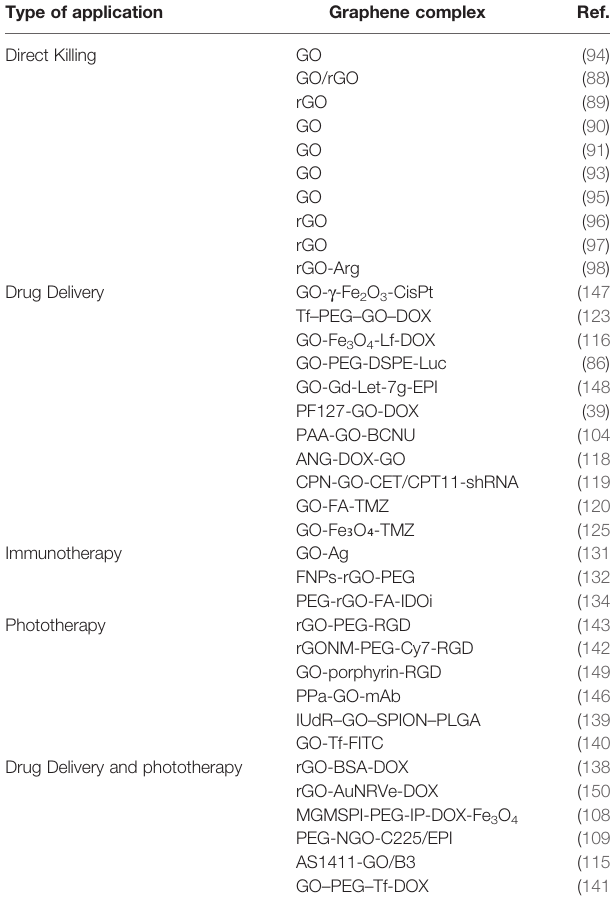
TABLE 2 | A brief summary of GO in glioma therapeutic